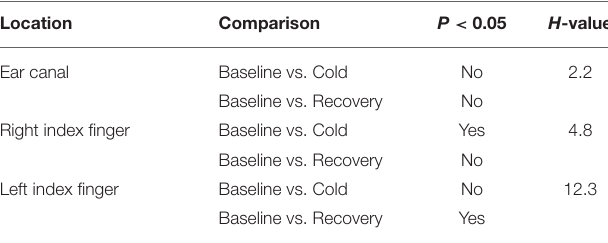
TABLE 1 | Summary of the statistical test results obtained from the Kruskal–Wallis test performed on the PTT measured from EC, RIF, and LIF of the